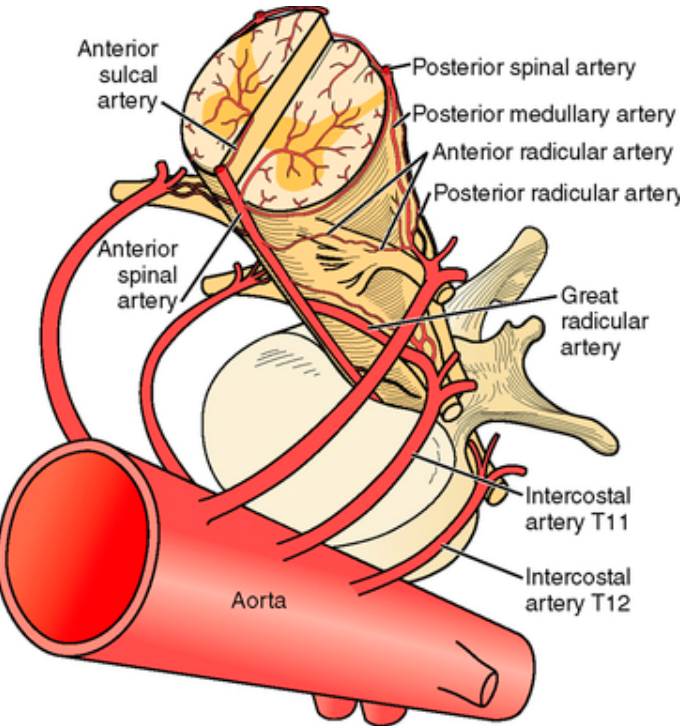
Figure 4. Axial view of the normal vascular anatomy of the spinal cord [20]. The occlusion of intercostal arteries after FET has been reported as a risk factor for SCI by Kozlov et al. [15]. Hori et al. described significant spinal cord perfusion from intercostal arteries originating from the false lumen as a significant risk factor for SCI